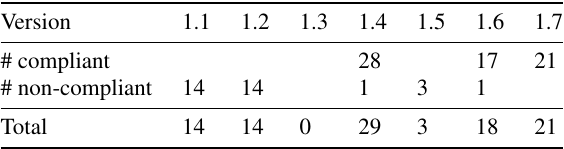
Table 1. Total number of schema compliant and non-compliant